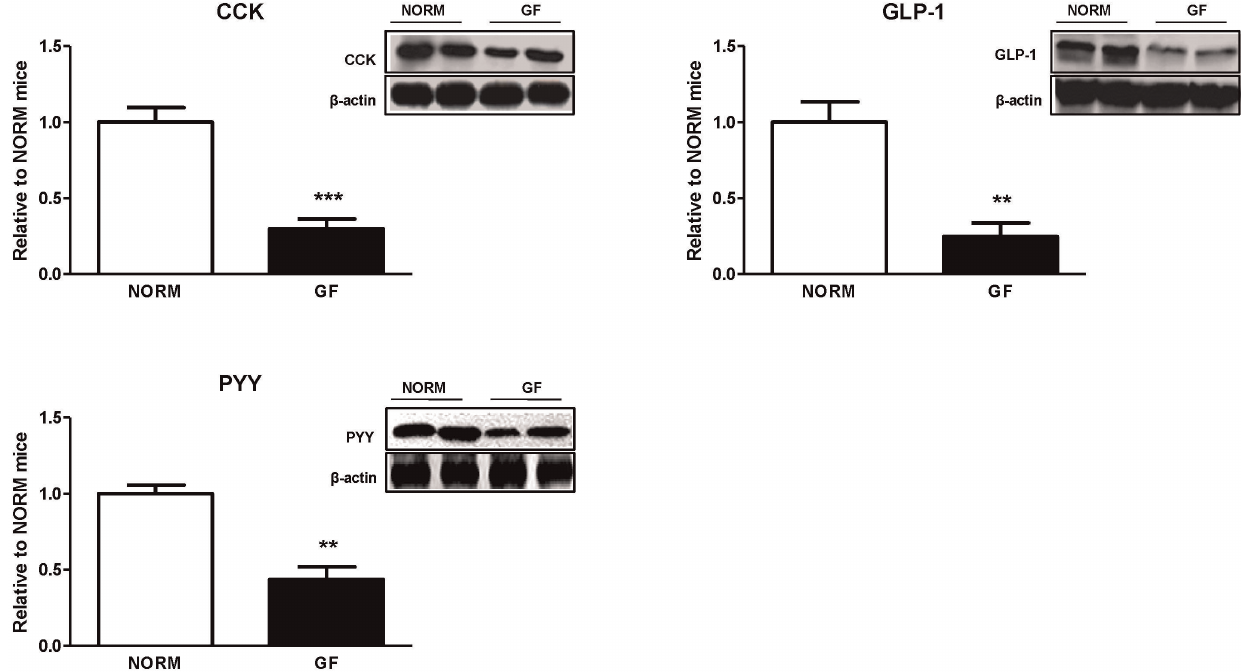
Figure 4. Intestinal epithelial protein expression of satiety peptide in GF and NORM mice. GF mice exhibited down-regulation of proximal intestinal CCK, GLP-1 and PYY relative to NORM mice. Data are expressed as means 6 SEM. **P , 0.01, ***P , 0.001, compared to NORM mice.